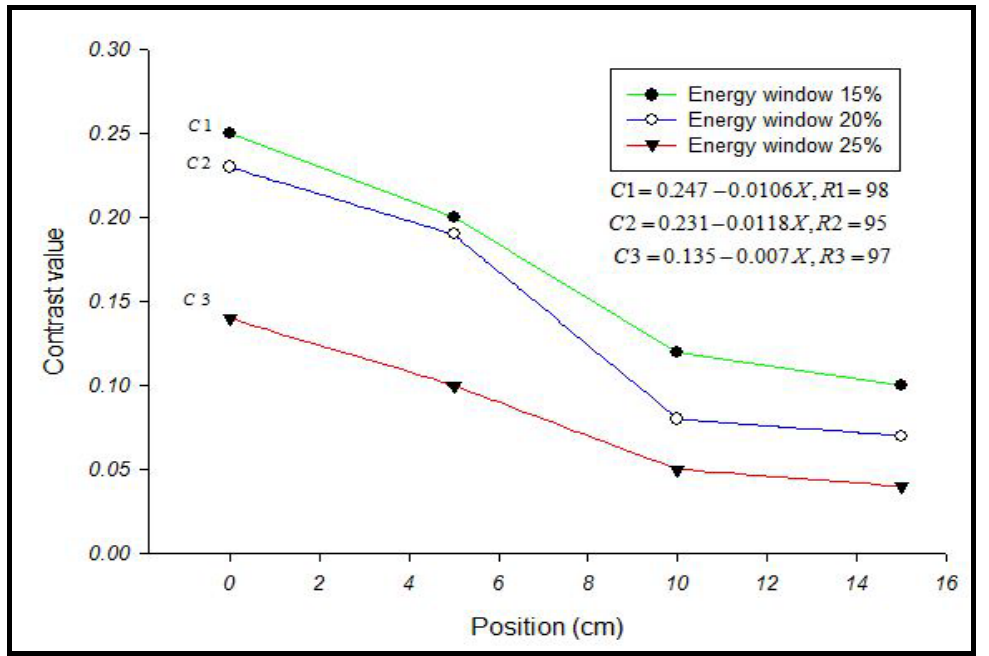
Figure 7. Effect of the positioning on defect contrast in the inferior region of myocardial SPECT image in different energy windows.